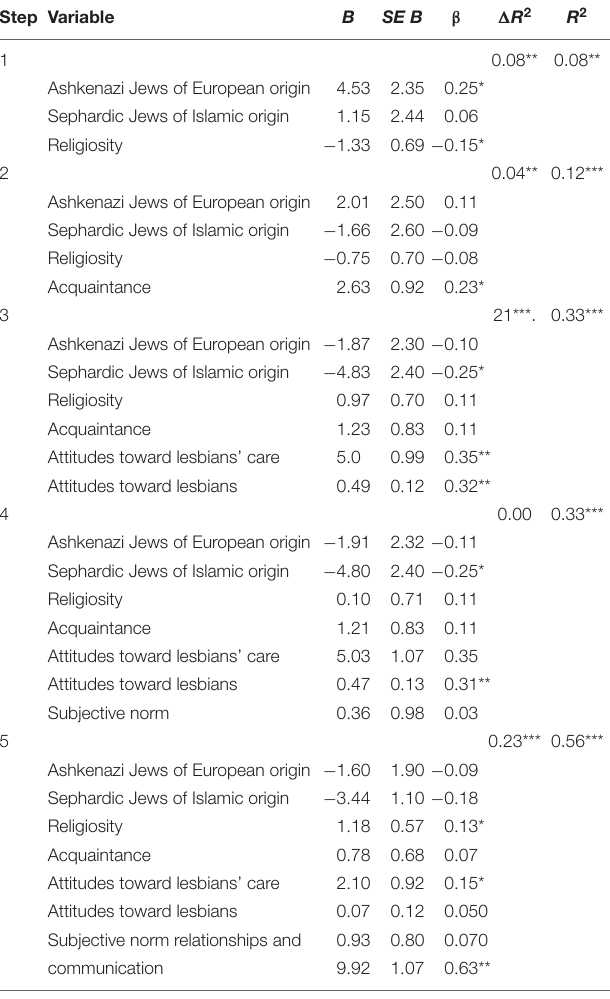
TABLE 5 | Hierarchical multiple regression analysis explaining the variability of perception of quality of perinatal nursing care the nurses provided the lesbians ( N =